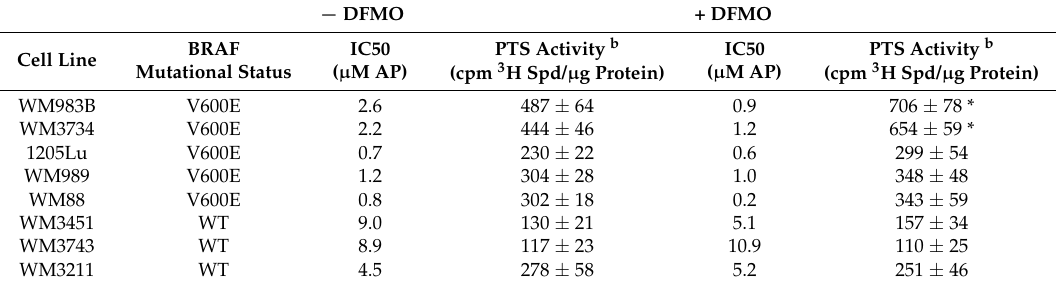
Table 1. Polyamine transport activity and sensitivity to AP in human melanoma cells with different BRAF mutational status cultured ± DFMO a